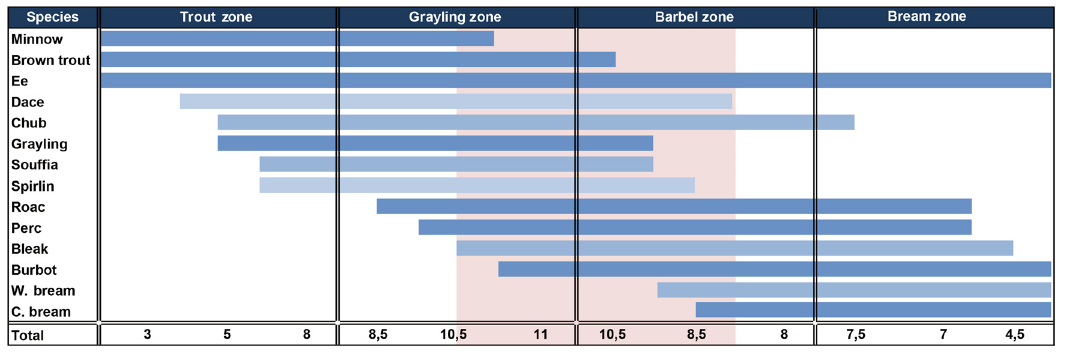
Figure 10: Ecological requirements of the fi sh species identi fi ed at Ranchot, plotted along the longitudinal zonation de fi ned by Huet ( 1949 ) , from upstream ( Trout zone ) to downstream ( Bream zone ) . Total: number of Ranchot species present in sub - zone; pink area: minimal river area including all of the species documented at